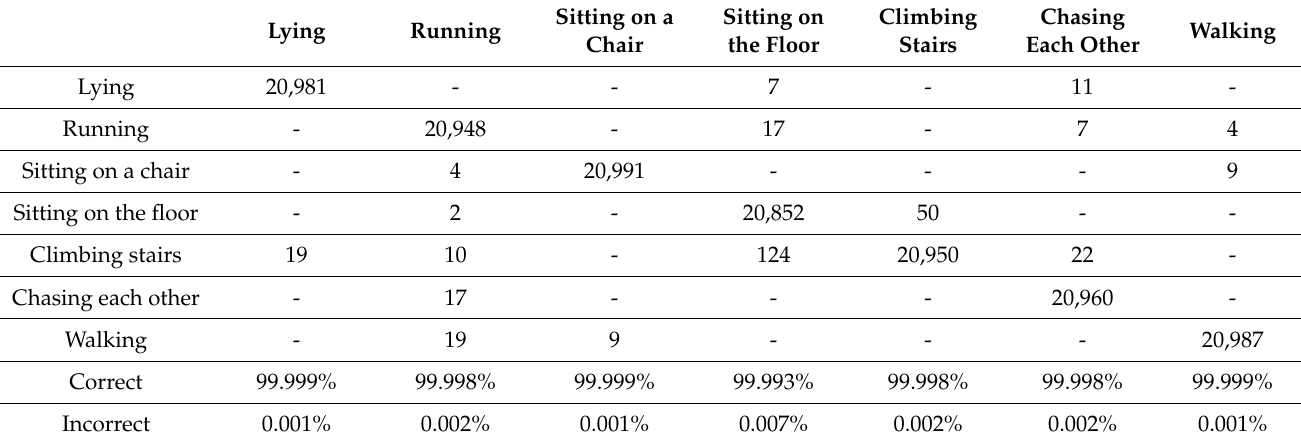
Figure 7. An example of a graph of training progression for 900 epochs and 100 hidden units. Tables 4 and 5 present the confusion matrices for 150 hidden units and 300 epochs and for 200 hidden units and 900 epochs, respectively. The rows in each table indicate the classification result, and the columns indicate the actual class. The diagonal cells of the matrix indicate the successful classifications, whereas the non-diagonal cells indicate misclassifications. A greater number of errors were found in the training results in Table 5 than in Table 4, despite the higher numbers of epochs and hidden units. Table 4. Confusion matrix for 150 hidden units and 300 epochs.